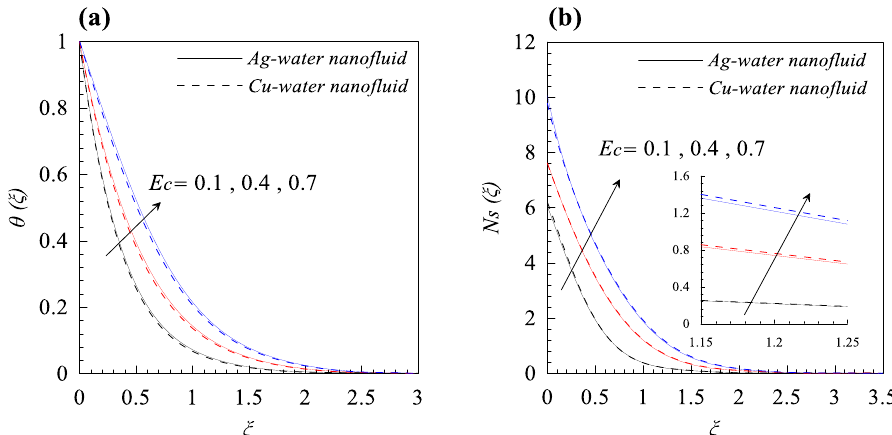
Figure 5. Effects of variable thermal conductivity parameter  on ( a ) temperature distribution ( )   and ( b ) entropy generation